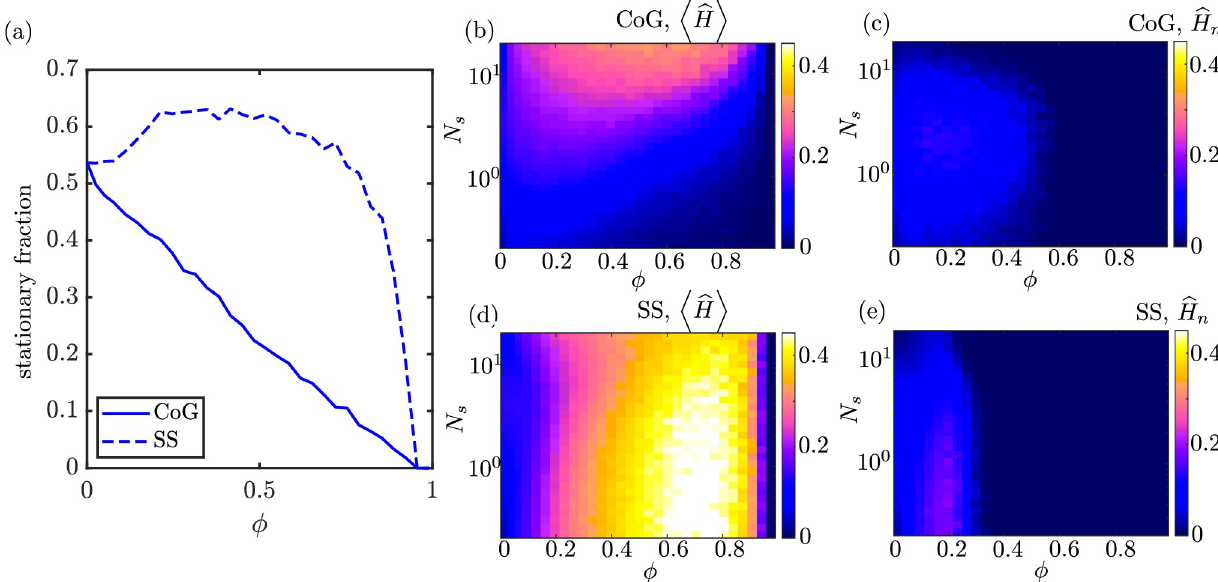
Fig 9. Effect of mitophagy when total mitochondrial number is limited. (a) Fraction of mitochondria in the stationary state as a function of increasing mitophagy threshold, for the CoG model (solid line) and the SS model (dashed line), with parameters set such that f s = 0.53 at ϕ = 0. (b) Mitochondrial health, normalized by the total number of mitochondria per site, averaged over all demand sites, for the CoG model. (c) Normalized mitochondrial health at most distal demand site, for the CoG model. (d-e) Analogous plots of normalized average health and distal site health for the SS model. Normalizing by total mitochondrial number is equivalent to a system where the total mitochondrial content is held fixed with the onset of mitophagy (S4 Fig).